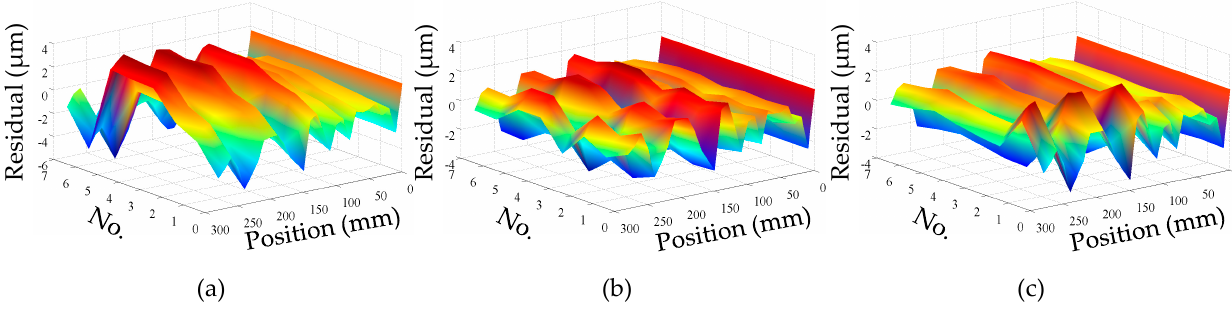
Figure 13. The fitting results of the artificial neural network (ANN) model (measured positioning error marked with dots) in experiment I.